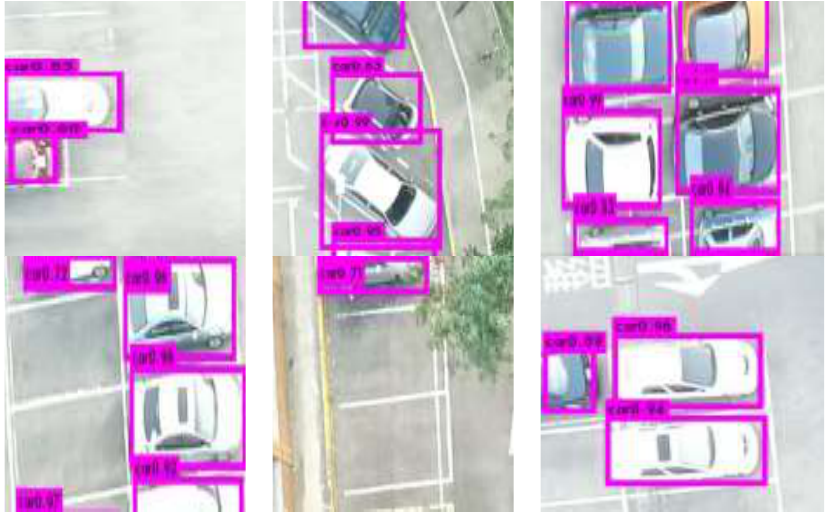
Figure 5. Detection results after using K-means++.